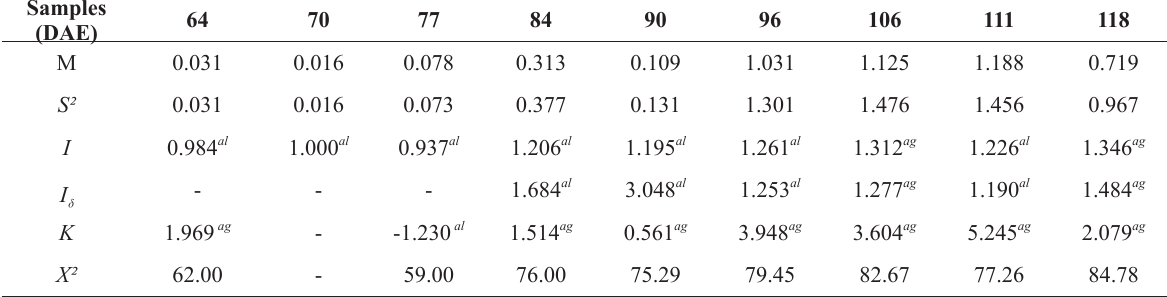
Dispersion indices of the spatial distribution of the stink bug E. heros in cotton, Dourados - MS, Brazil. Samples